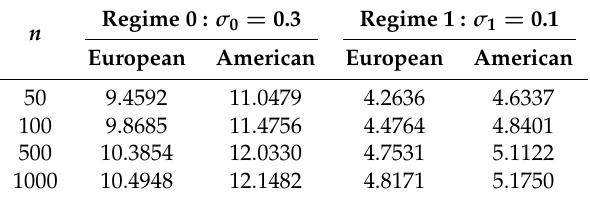
Table 7. Floating strike currency lookback option prices under regime-switching. Regime 0 : σ 0 = 0.3 Regime 1 : σ 1 = n